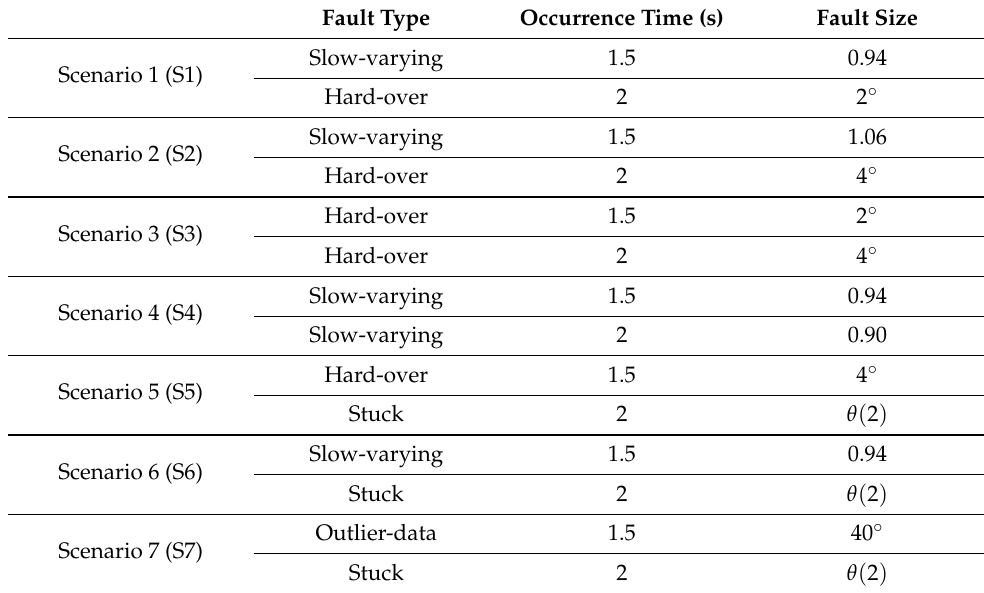
Table 8. Representative scenarios of the sequential multiple